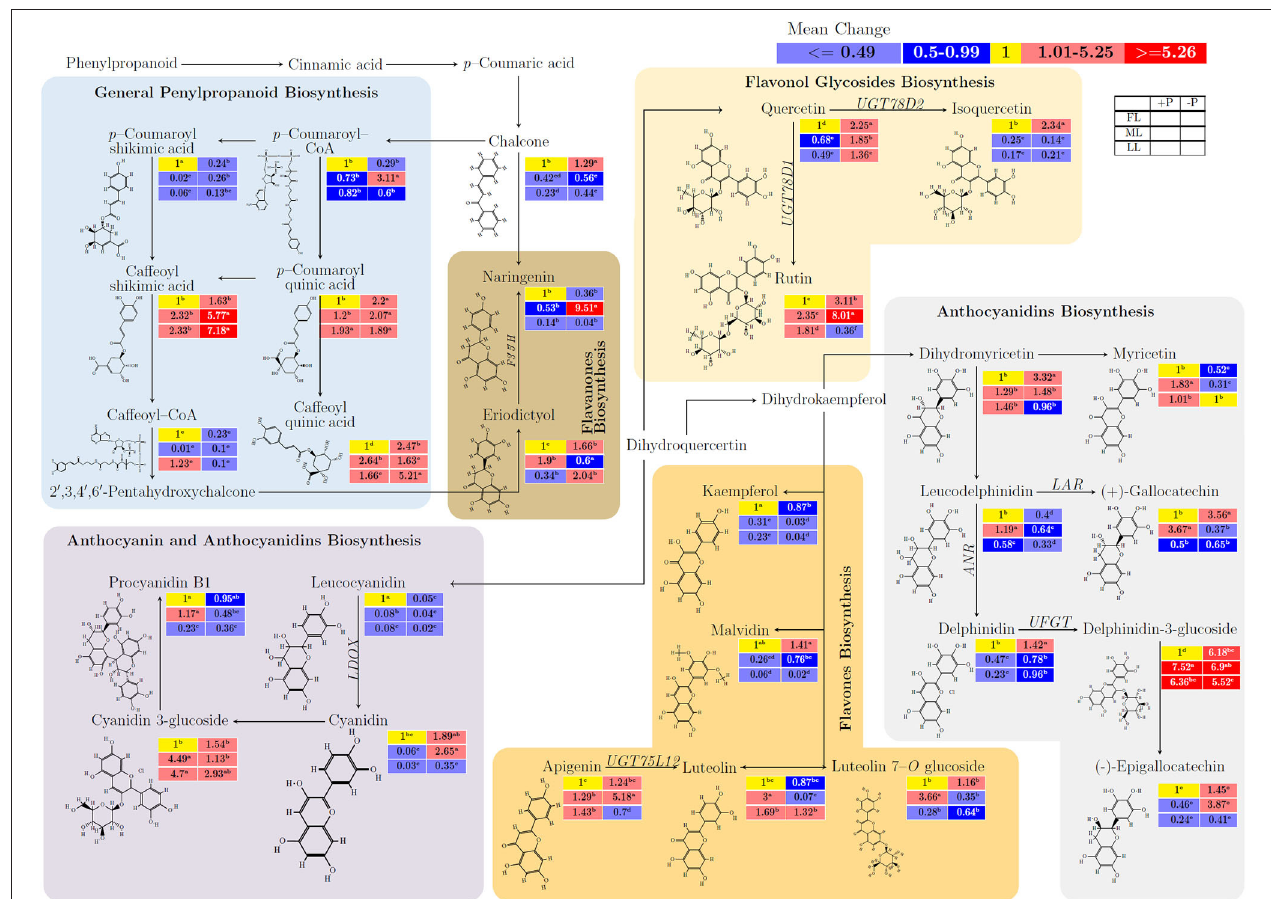
FIGURE 4 | The interactive effects of light and P on the biosynthesis of flavonoids and/or related anaplerotic pathway metabolites of flavonoids in young shoots of Fengqing cultivar measured by ultra-performance liquid chromatography-quadrupole-time of flight mass spectrometry (UPLC–Q–TOF/MS). The mean of each metabolite followed by a different letter in the heatmap table indicates significant change due to light and P treatments. In the heatmap, red boxes represent the value > 1 and are separated into dark red and mild red by the mean value of the figured pathway data ( > 1) and subsequently < 1 with blue color and mean value separated into mild blue and dark blue from figured pathway data ( < 1). The yellow box represents the normalization value. The blank table in the legend shows the position of the mean P and light treatment value of the